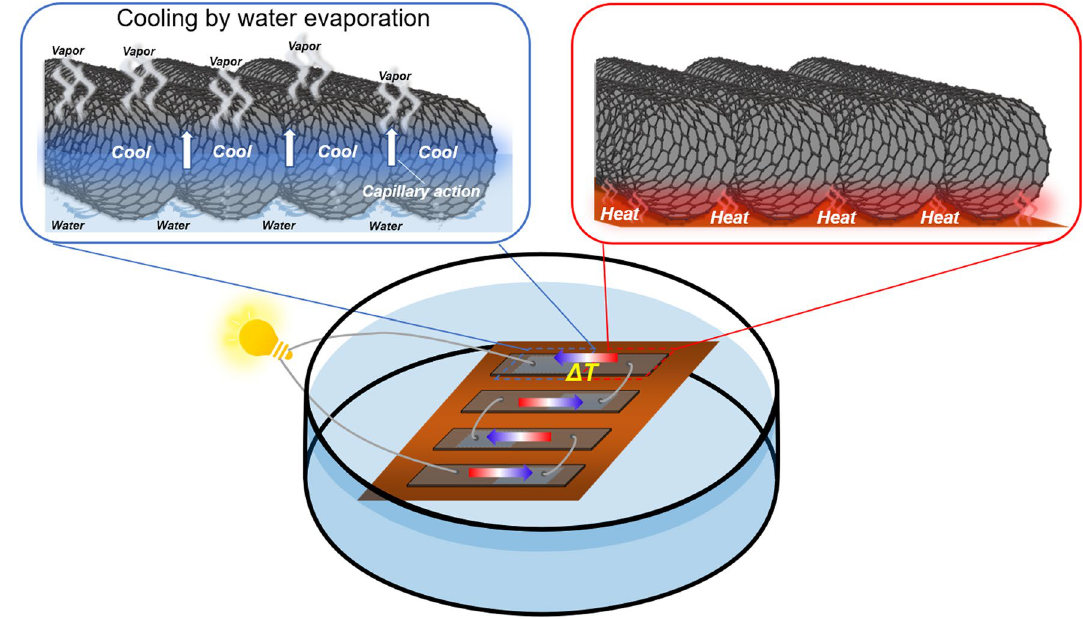
Figure 1. Design principle of water-floating SWCNT film TEGs. Each thin film is divided into water-permeable and water-nonpermeable areas. In the former, water passes through the gaps in the SWCNT bundle to reach the surface via capillary action. The surface temperature is reduced via an evaporation-induced cooling. Thus, a temperature gradient is created in each film, with output voltage generated via the Seebeck